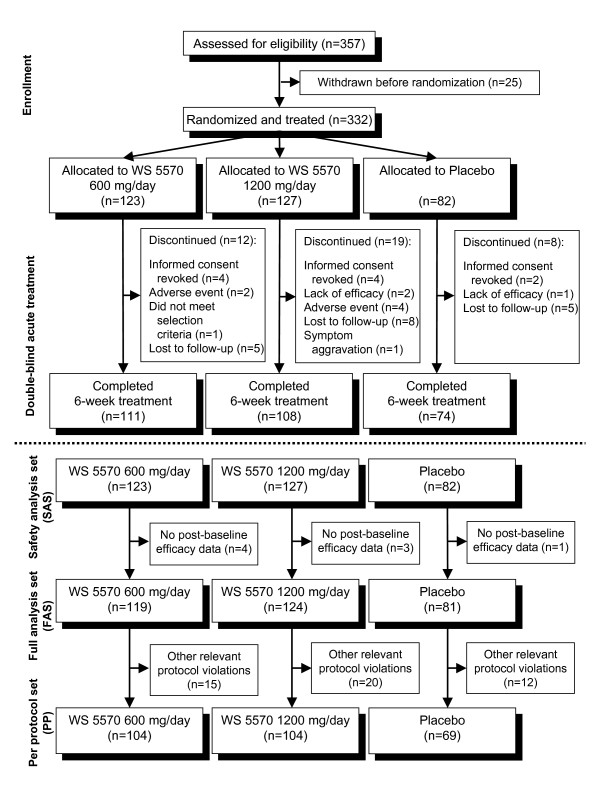
Patient accounting and datasets for analysis.